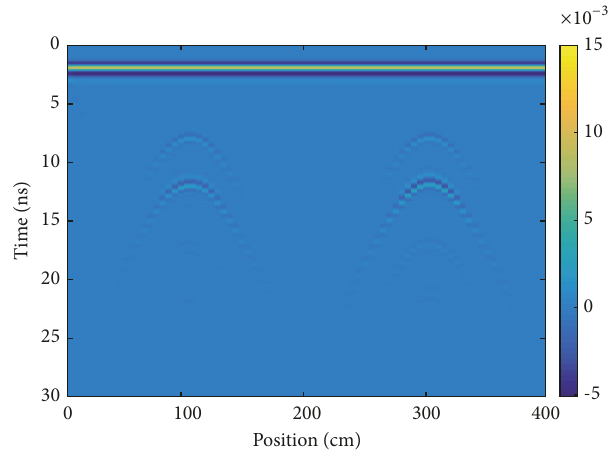
Figure 18: GPR simulation section with traditional FDTD